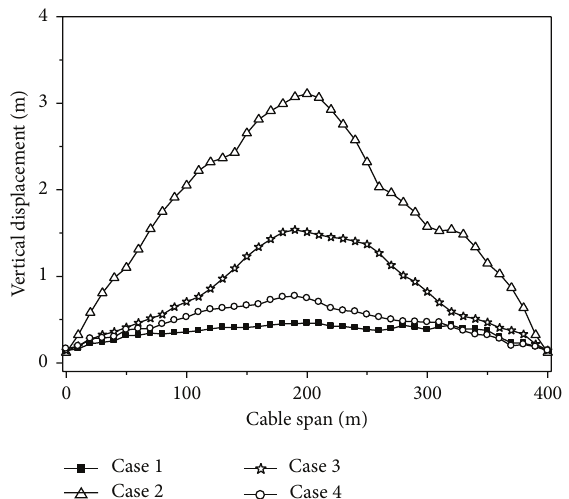
Figure 5: Vertical displacements of the cable under different anal- ysis cases.